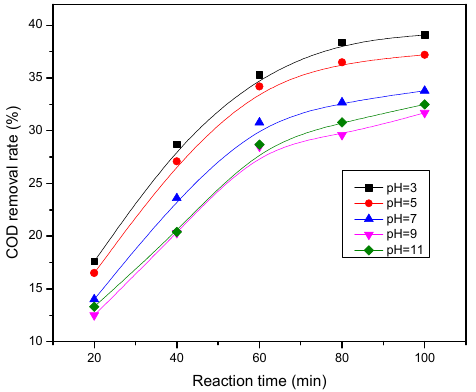
Figure 6. Influence of initial pH value on the COD removal rate.